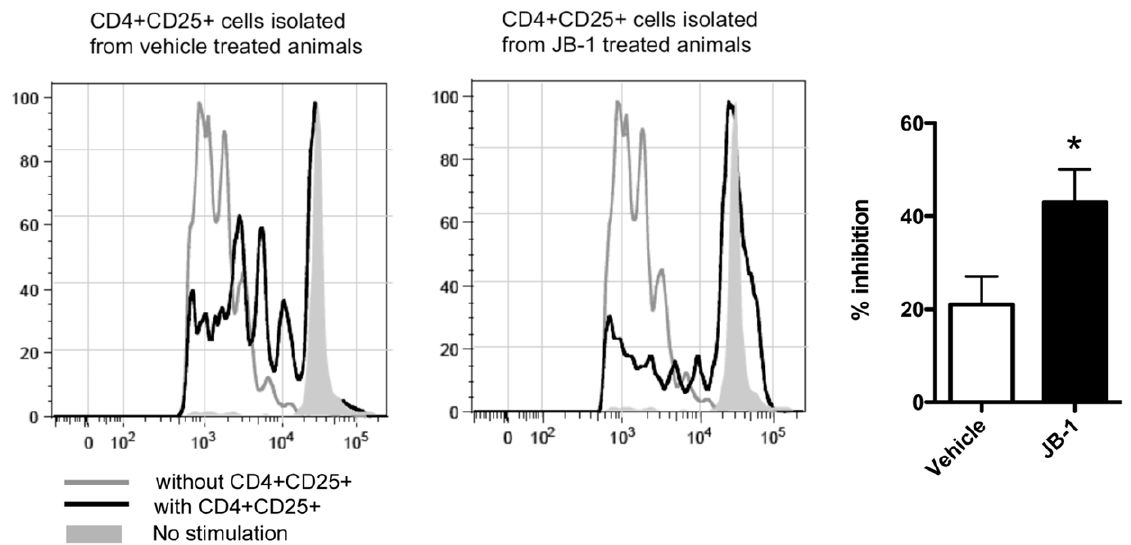
Figure 2. JB-1 enhances the in vitro suppressive capacity of MLN CD4 + CD25 + cells. (A) CFSE plots, representative from 4 similar experiments, of the T effector–cell proliferation in the absence (tinted histograms), and presence (open histogram), of T regulatory cells at a Treg to T effector cell ratio of 1:8 (B) Percentage of inhibition of effector T-cell proliferation by T regulatory cells from treated (JB-1) and vehicle-fed controls. Data presented as mean 6 SEM n=4 *P , 0.05. CFSE=carboxyfluorescein diacetate succinimidyl